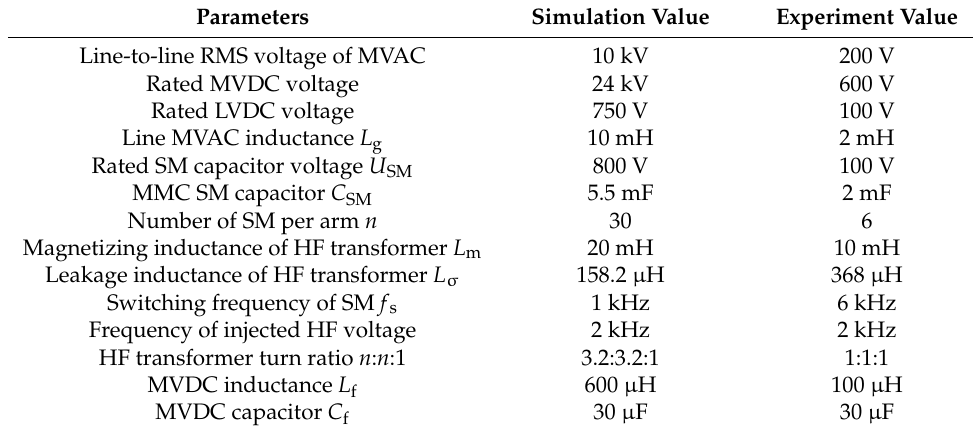
Table 1. Parameters of proposed PET.